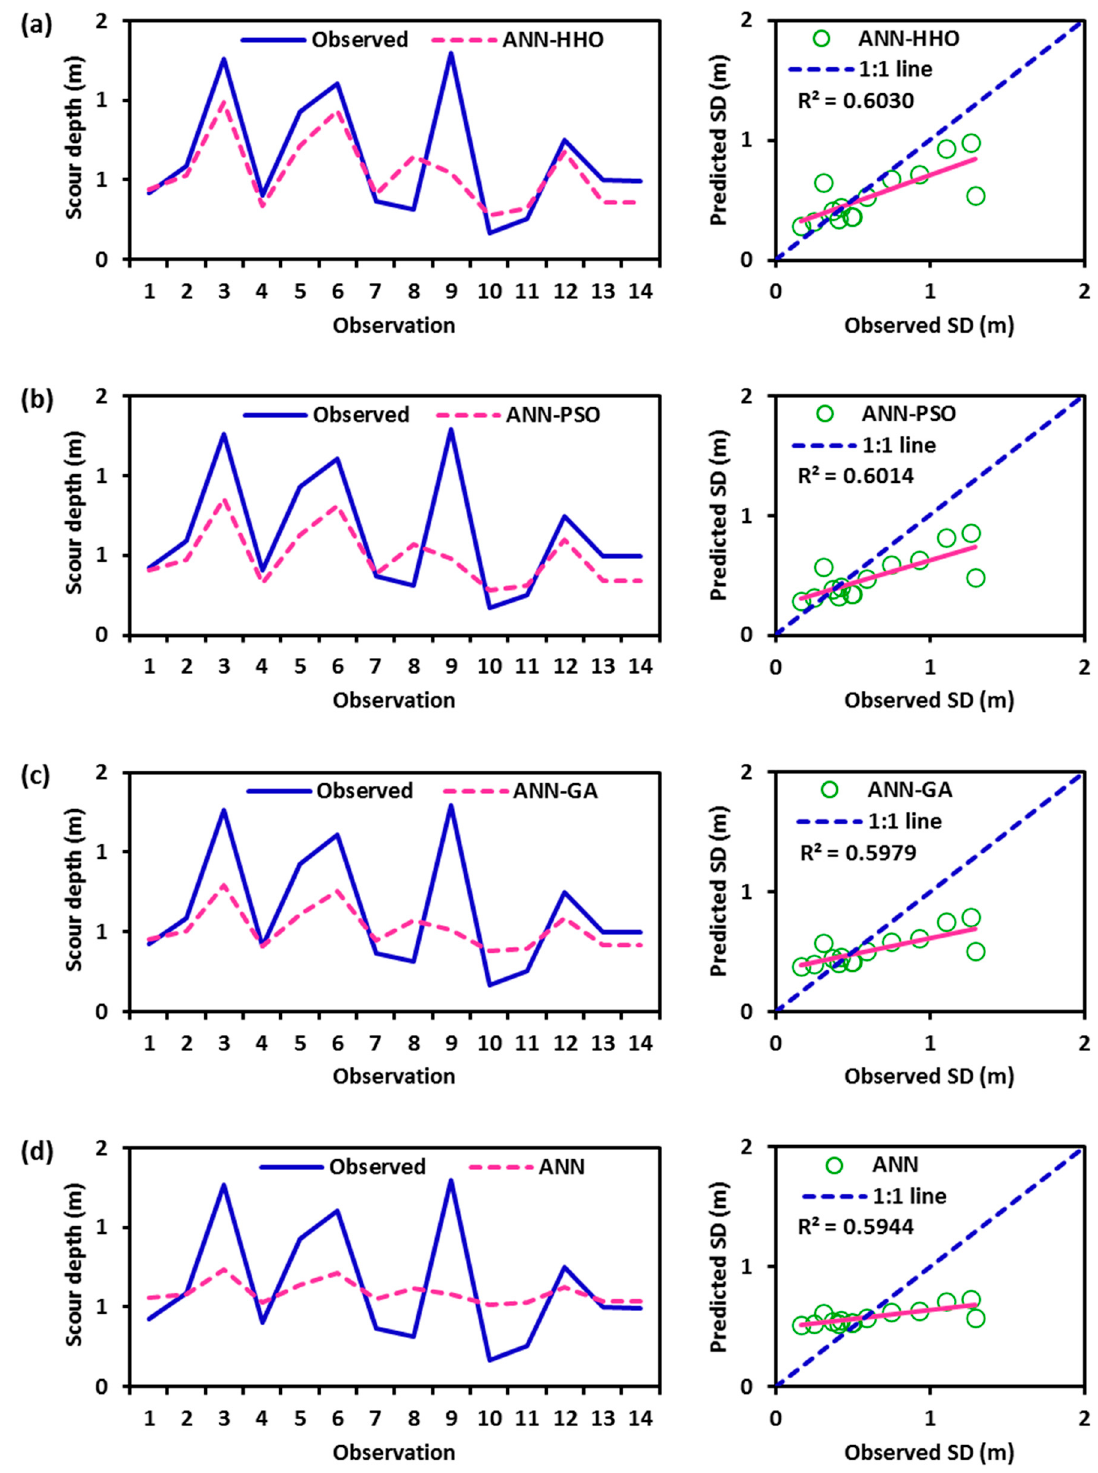
Figure 5. Line and scatter plots of ( a ) ANN-HHO, ( b ) ANN-PSO, ( c ) ANN-GA, and ( d ) ANN models during the testing period.